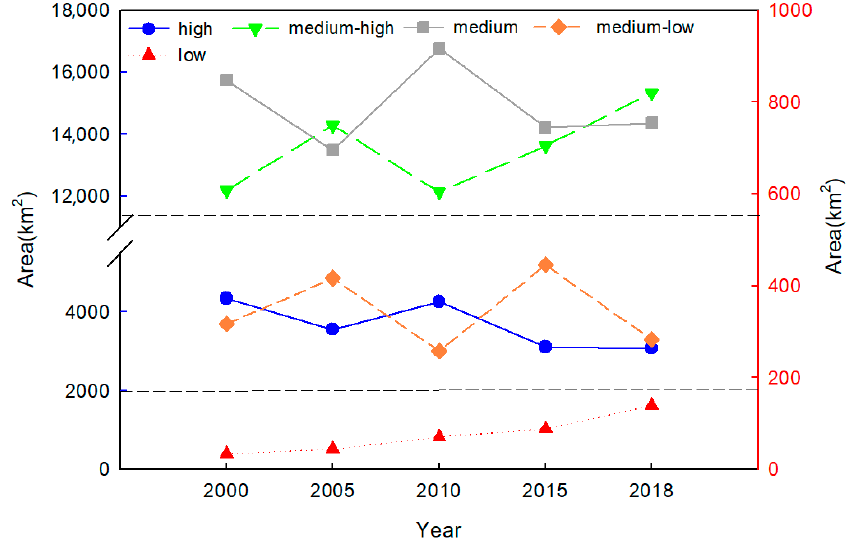
Figure 4. The area of the zone in different LES levels from 2000 to 2018: high, medium − high, medium, medium − low, and low levels. The right Y -axis represents the area variation of the low level of LES, the left Y -axis represents the area variation of the other four levels of LES.